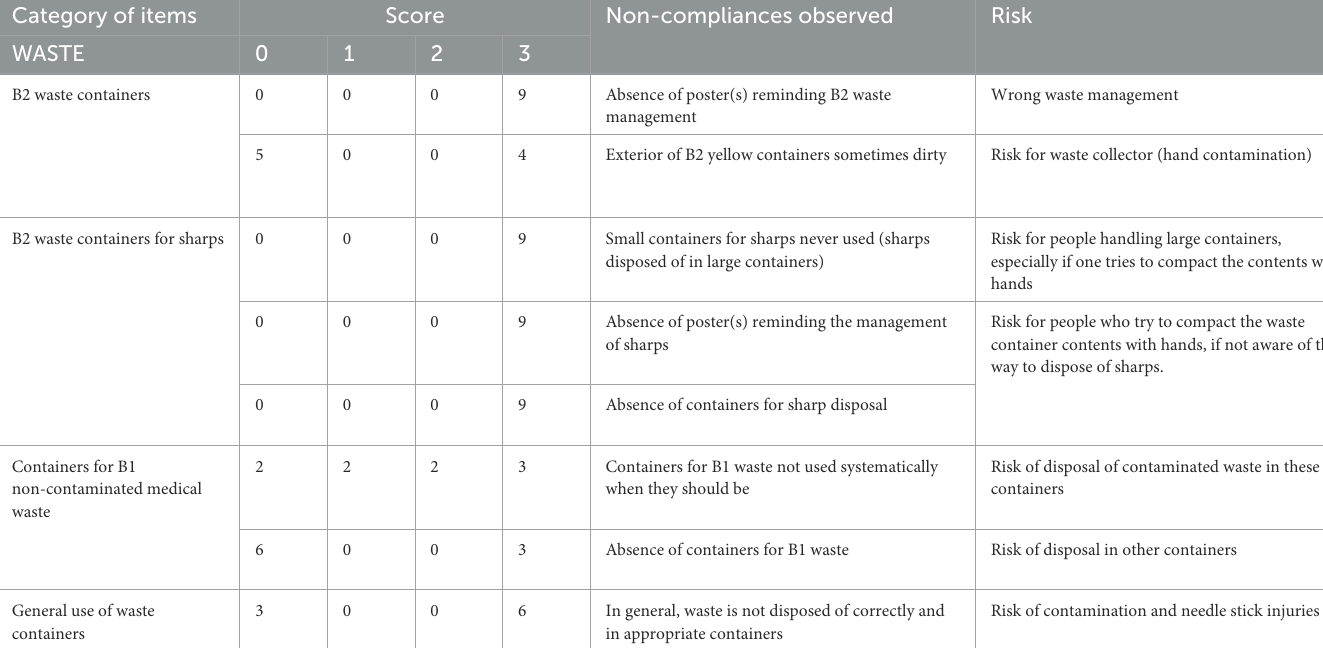
TABLE 2E Biosecurity deficiencies observed when performing the internal audit in the Equine class 3 area—category “WASTE”. Category of